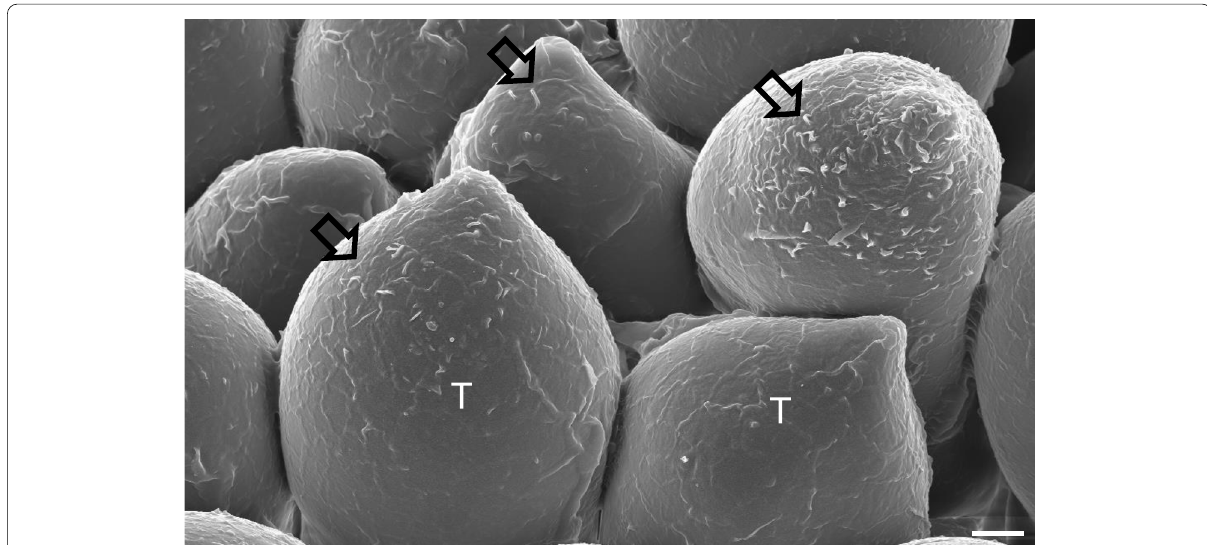
Fig. 1 Scanning electron micrograph of Puccinia miscanthi teliospores on the leaf surface of Miscanthus sinensis . The specimen was imaged using an axial secondary electron detector. Arrows: mucilage. T: teliospore. Scale bar